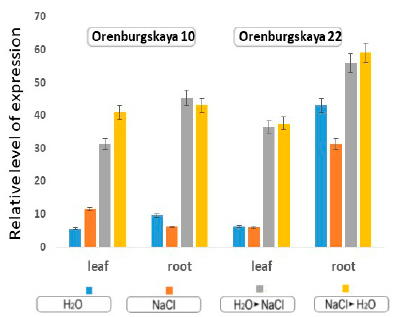
Figure 9. Expression gene MnSOD in the leaves and roots of 10-day-old wheat based on the mean values and their standard deviations.